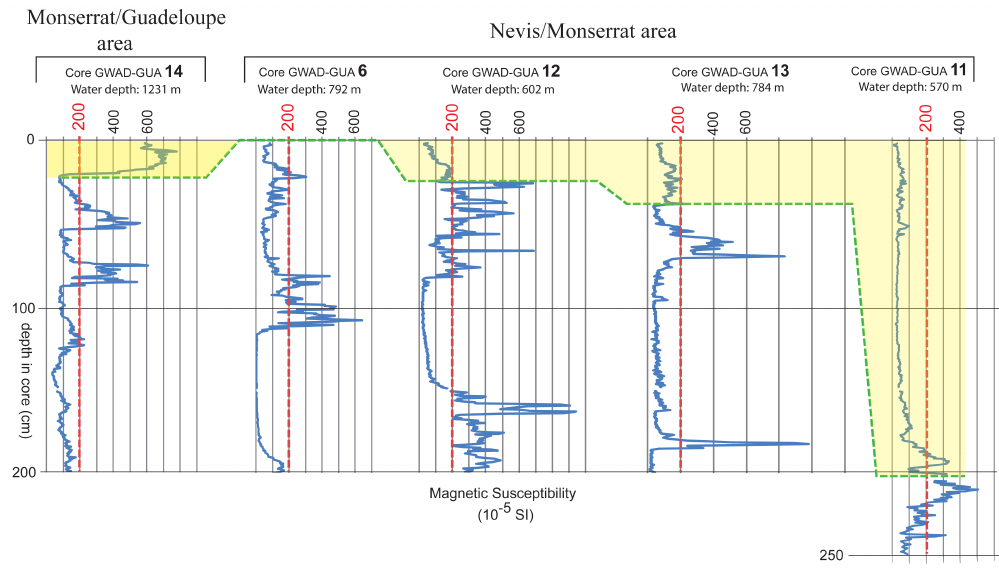
Fig. 10. Correlation of recent homogenite base between cores GWAD-GUA 11 to GWAD-GUA 14.